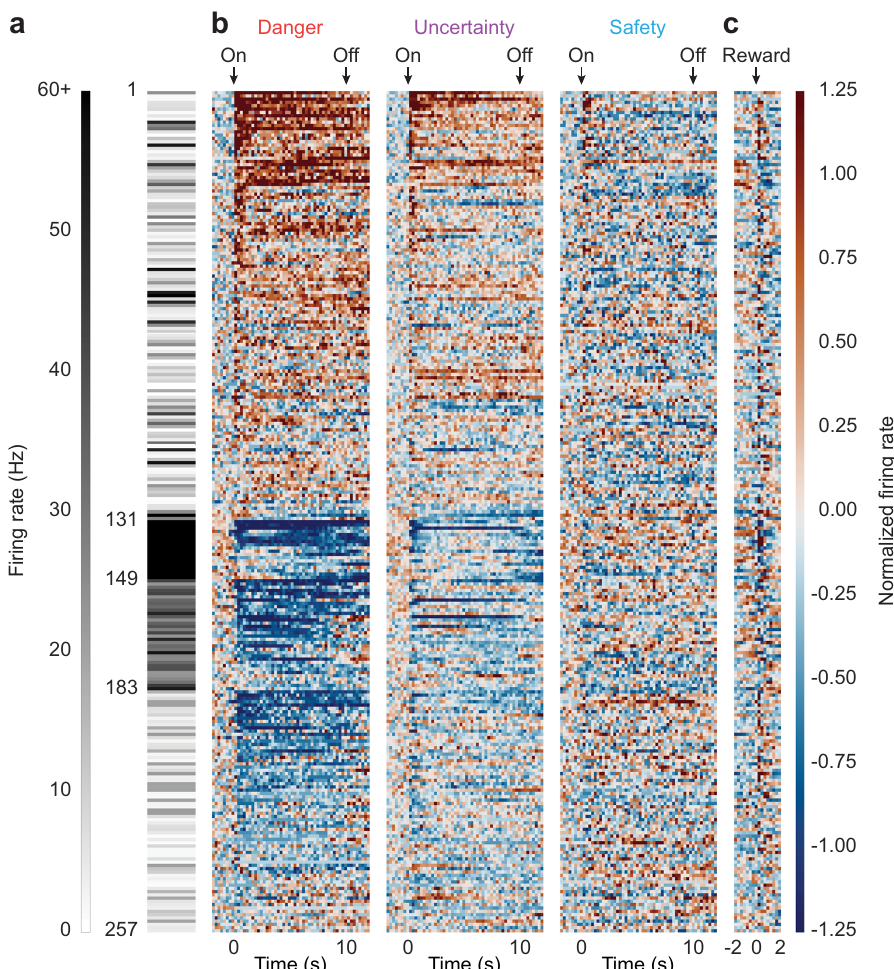
Fig. 2 Heat plot of cue-responsive neurons. a Heat plot showing mean baseline fi ring rate (10 s prior to cue onset) for each cue-responsive neuron ( n = 257). Color scale for baseline fi ring rate is shown to the left, white indicates low baseline fi ring rate and black high baseline fi ring rate. b Mean normalized fi ring rate for each cue-responsive neuron, from 2 s prior to cue onset to 2 s following cue offset, in 250 ms bins for each of the three trial types: danger, uncertainty, and safety. Cue onset (On) and offset (Off) are indicated by black arrows. All cue-responsive neurons are sorted by the direction of their response to danger cue (cue-excited, n = 131, maroon, top; cue-inhibited, n = 126, dark blue, bottom). Color scale for normalized fi ring rate is shown to the right. A normalized fi ring rate of zero is indicated by the color white, with greatest increases maroon and greatest decreases dark blue. c Mean normalized fi ring rate for each cue-responsive neuron from 2 s prior to 2 s following reward delivery, advancement of pellet dispenser (colors maintained from b ). Reward delivery is indicated by black Intermediate fi ring neurons also showed a fi ring pattern (uncertainty vs. safety). Separate 95% bootstrap con fi dence consistent with a neural signal for relative threat. At cue onset, intervals were constructed for cue onset ( fi rst 1 s cue interval), there was greatest fi ring inhibition to danger, lesser inhibition to late cue (last 5 s cue interval), and delay (2 s following cue offset) uncertainty and least inhibition to safety. Firing inhibition that periods. Observing 95% bootstrap con fi dence intervals that do was speci fi c to danger and uncertainty was maintained for the not contain zero supports interpretations of a fi ring departure remainder of cue presentation (Fig. 3c). In support, ANOVA from baseline and differential cue fi ring. revealed a signi fi cant main effect of cue ( F 2,66 = 27.25, p = 2.36 × Low fi ring neurons showed selective fi ring inhibition to threat cues at onset (danger: M = − 0.37, 95% CI [ − 0.44, − 0.29]; uncertainty: M = − 0.14, 95% CI [ − 0.22, − 0.06]) and during late cue (danger: M = − 0.27, 95% CI [ − 0.34, − 0.19]; uncertainty: M = − 0.09, 95% CI [ − 0.15, − 0.04]; Fig. 3b). Low fi ring neurons showed differential fi ring to danger and uncertainty at onset ( M = − 0.23, 95% CI [ − 0.31, − 0.13]; Fig. 3b, left) and during late cue ( M = − 0.17, 95% CI [ − 0.25, − 0.09]; Fig. 3b, middle). Similar fi ring was observed to uncertainty and safety at onset ( M = − 0.08, 95% CI [ − 0.19, 0.02]; Fig. 3b, left), but differential fi ring was observed during late cue ( M = − 0.14, 95% CI [ − 0.25, − 0.04]; Fig. 3b, middle) and delay ( M = − 0.12, 95% CI [ − 0.26, − 6.32 × 10 − 4 ]; Fig. 3b, right).